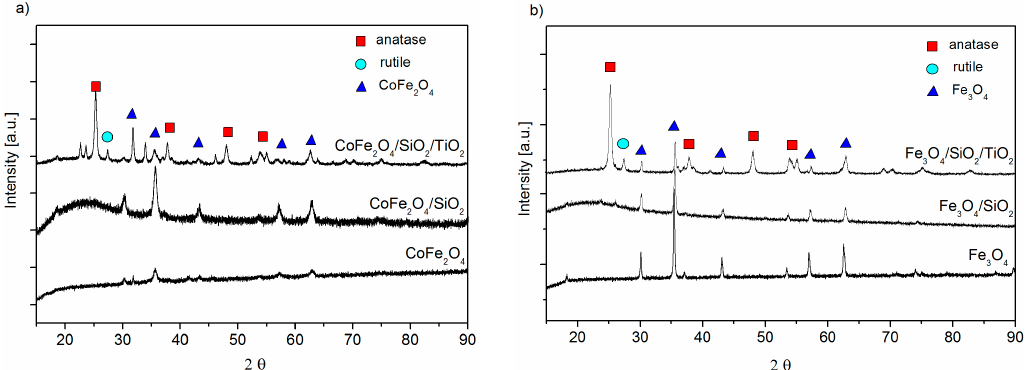
Figure 6. X ‐ ray diffraction patterns of the as ‐ prepared Fe 3 O 4 , Fe 3 O 4 /SiO 2 , Fe 3 O 4 /SiO 2 /TiO 2 _2 ( a ) and CoFe 2 O 4 , CoFe 2 O 4 /SiO 2 , CoFe 2 O 4 /SiO 2 /TiO 2 _2 ( b ). Table 2. Magnetic parameters of the uncoated and coated ferrite nanoparticles. Sample Label